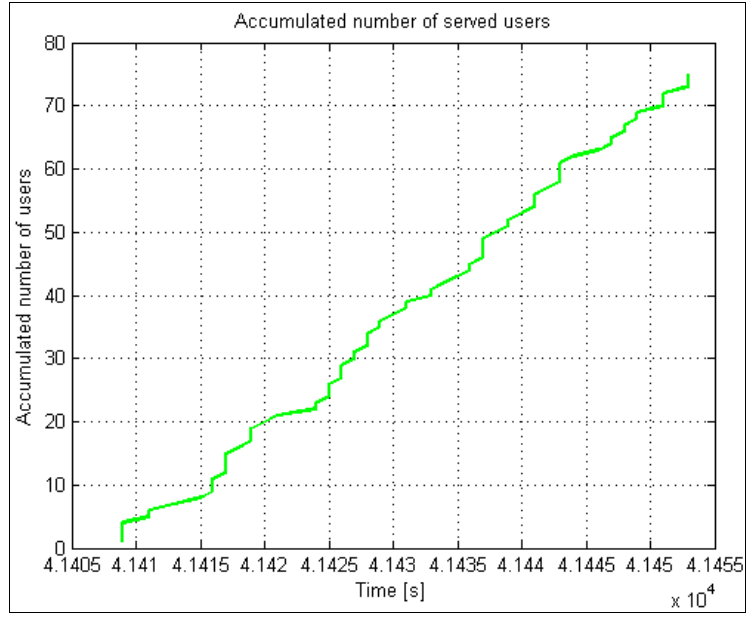
Figure 11. The total number of served users during the observation period. U = 75. Table 3. A comparison of the average utilization of the service system for our method and reference